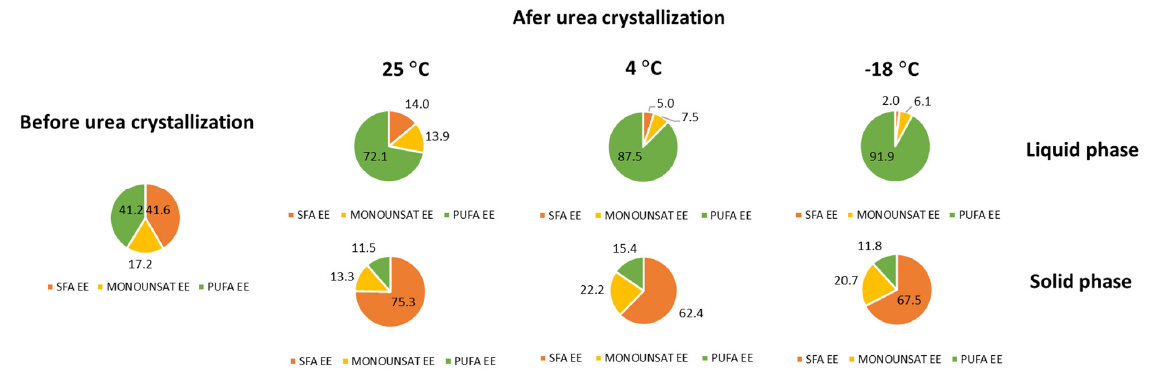
Figure 3. SAT, MONOUNSAT and PUFA EE percentages before and after urea crystallization. The temperature that allowed the highest PUFA EE enrichment in the liquid phase Table 2. C. cohnii FA EE percentages ( w / w) before and after urea was −18 °C, resulting in an increase from 41.3% (before urea complexation) to 91.9% (after urea complexation) (Figure 3, Table 2).